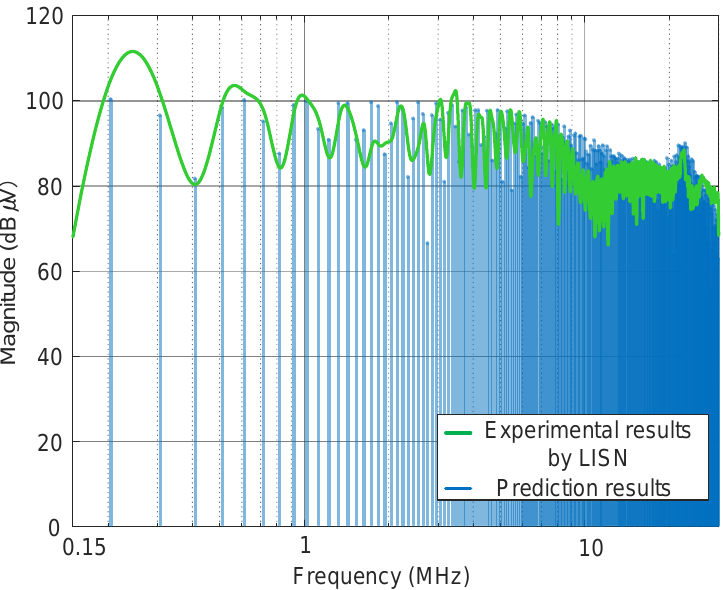
Figure 7. CM noise spectra comparison of a conventional boost converter (CBC) between prediction and measured results.